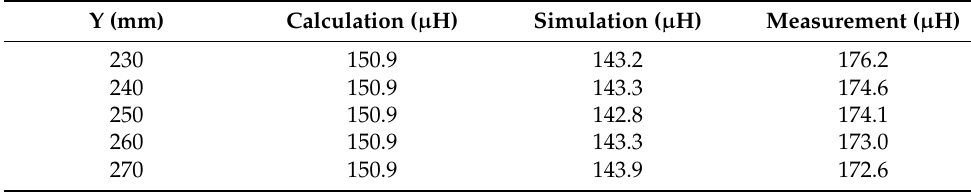
Table 5. Transformer leakage inductance with variation in parameter Y.